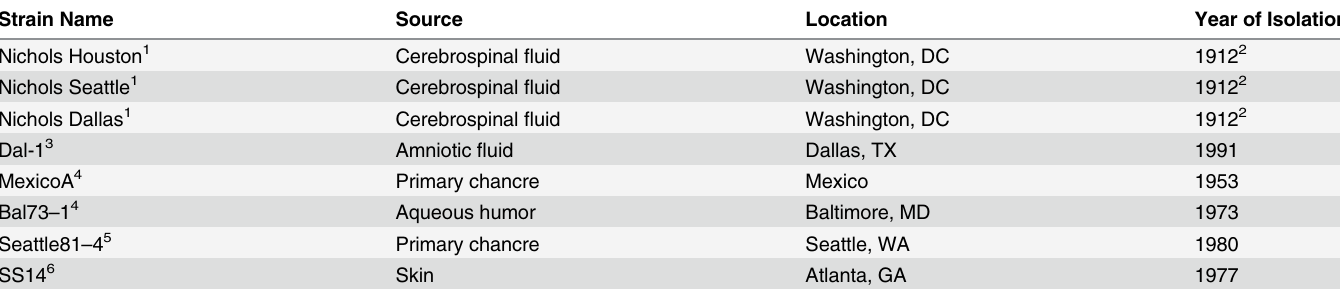
Table 1. T . pallidum subsp. pallidum strains used in this study. Strain